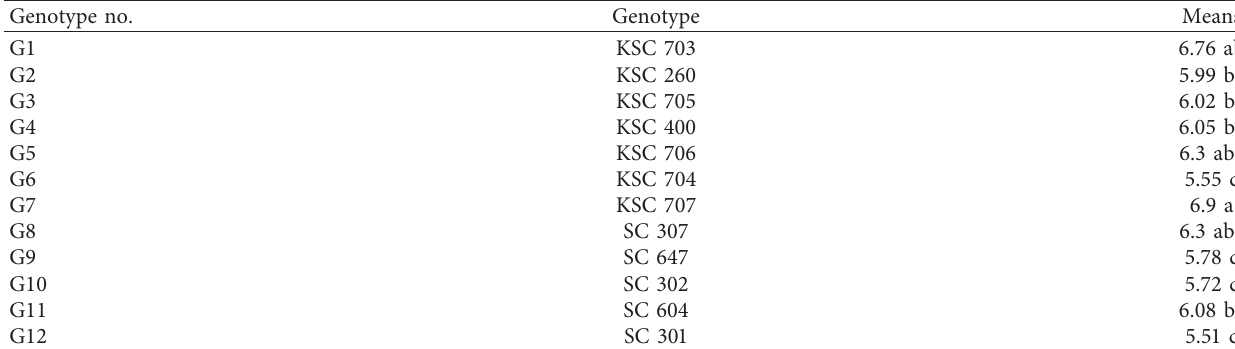
Table 2: Names and codes of maize varieties studied in the experiment. Genotype